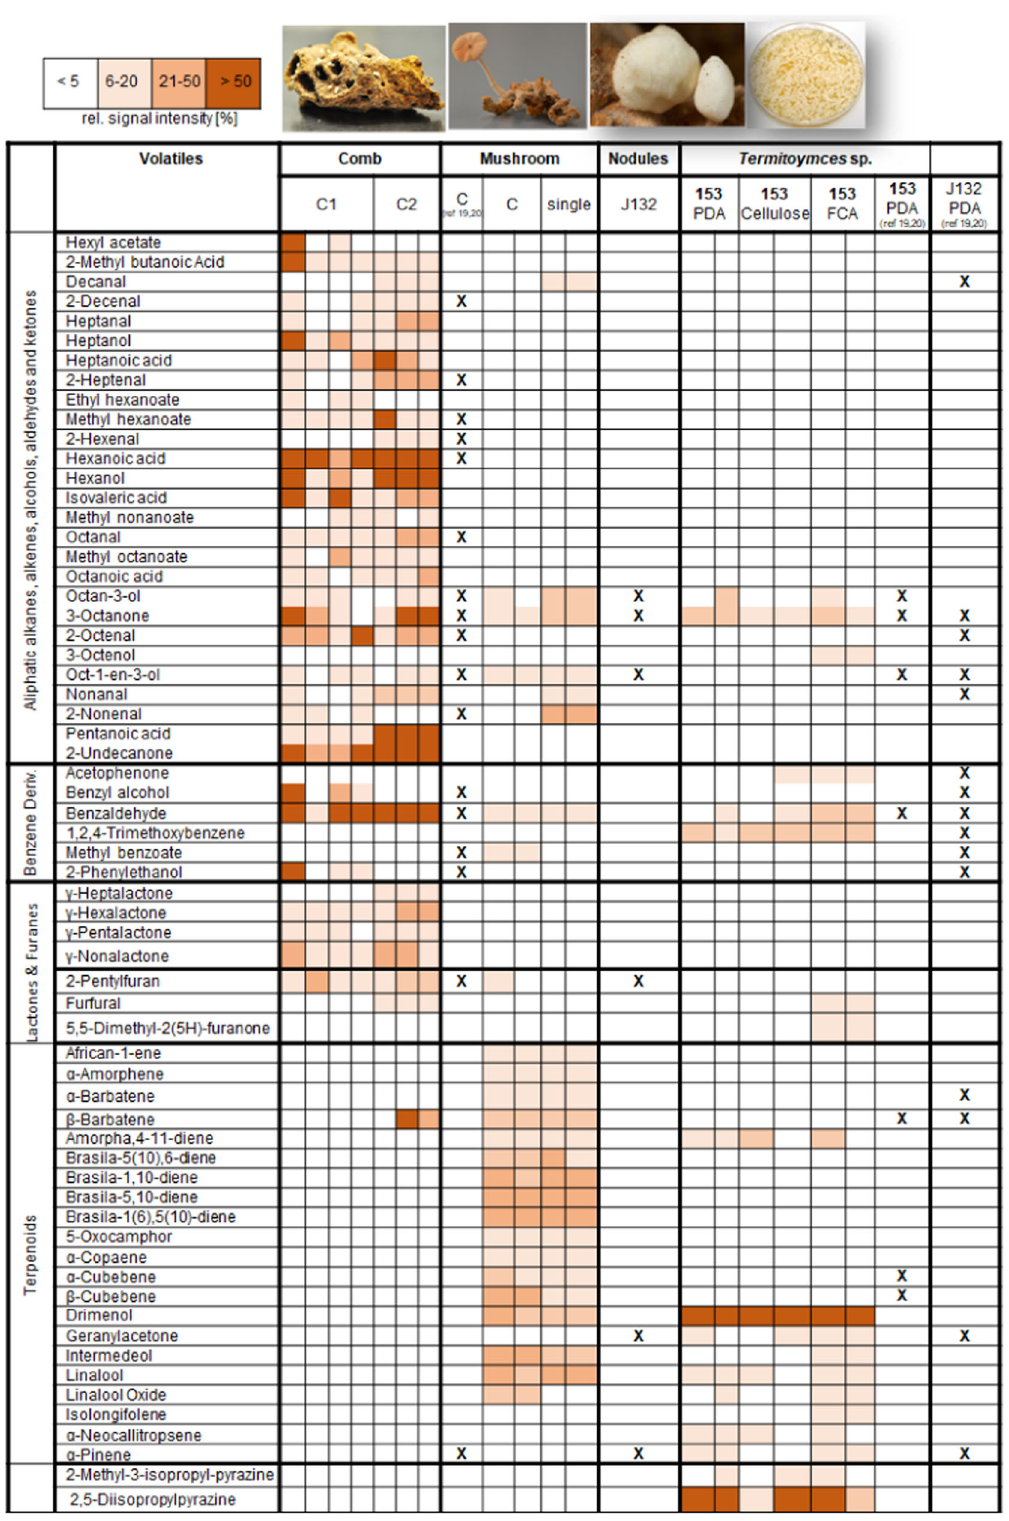
Fig. 2 Heatmap of emitted volatiles from fungus comb (C), T. cryptogamus mushroom (M), and axenic lab cultures of T. cryptogamus strain T153. Cultures of T. cryptogamus sp. T153 were grown on different solid media (PDA, Cellulose-Agar, FCA). Samples were measured as biological replicates with each column representing one replicate. Chemical features are depicted in relative signal intensities (based on the most abundant signal) using a color code. Reports of chemical feature in previous studies are marked with a bold X 20,21